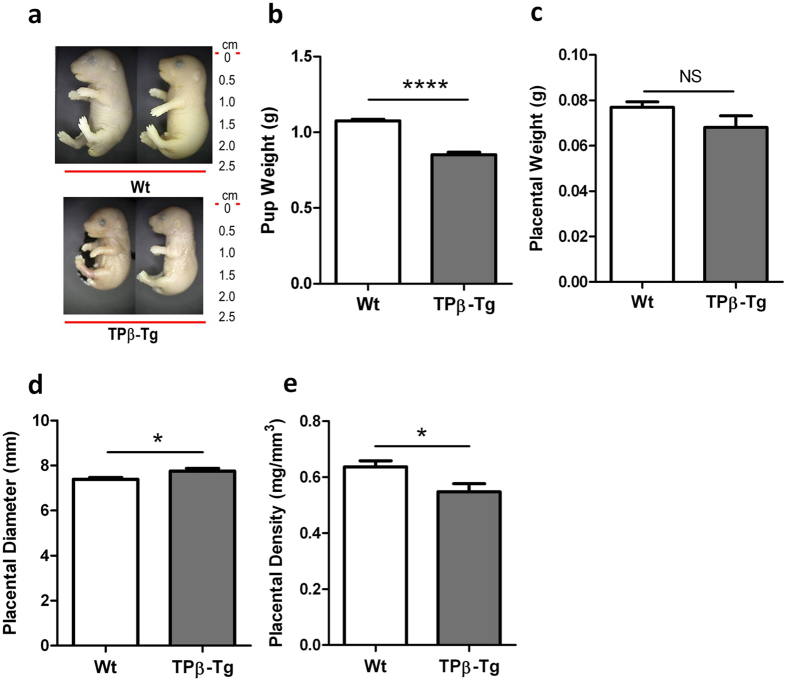
TPβ expression in mice produces a robust IUGR phenotype.(a) Representative images of pups born to Wt and TPβ-Tg dams at day 18.5 of gestation. All pups were born to n = 14 Wt and n = 7 TPβ-Tg dams. (b)Weight of pups born to Wt (□) and TPβ-Tg () dams. Pup weight data is representative of pups (n = 89) born to Wt dams and pups (n = 48) born to TPβ-Tg dams. Weight (c), diameter (d) and density (e) of the placentae from n = 54 pups born to Wt (□) and n = 20 pups born to TPβ-Tg () dams. The data are represented as mean ± SEM. Independent samples T-test, NS: not significant, *P < 0.05, ****P < 0.001.